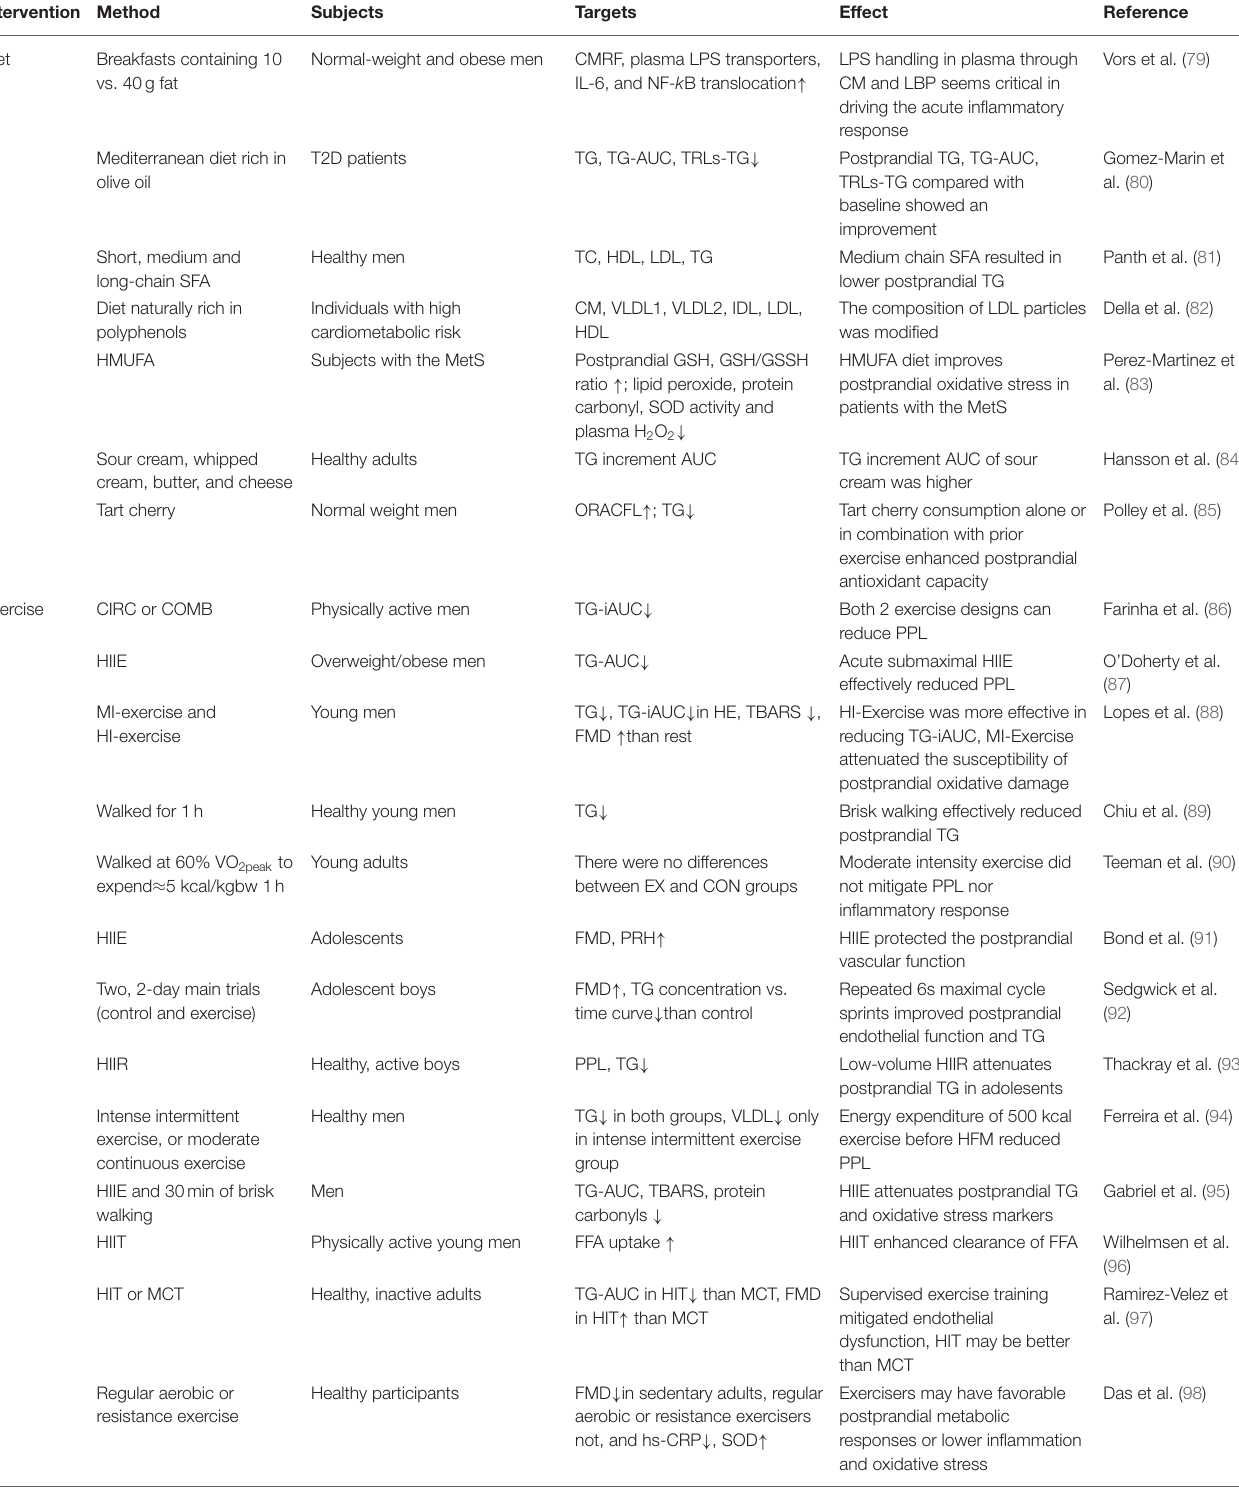
TABLE 1 | Studies of non-medicinal intervention of postprandial lipemia against AS. Intervention